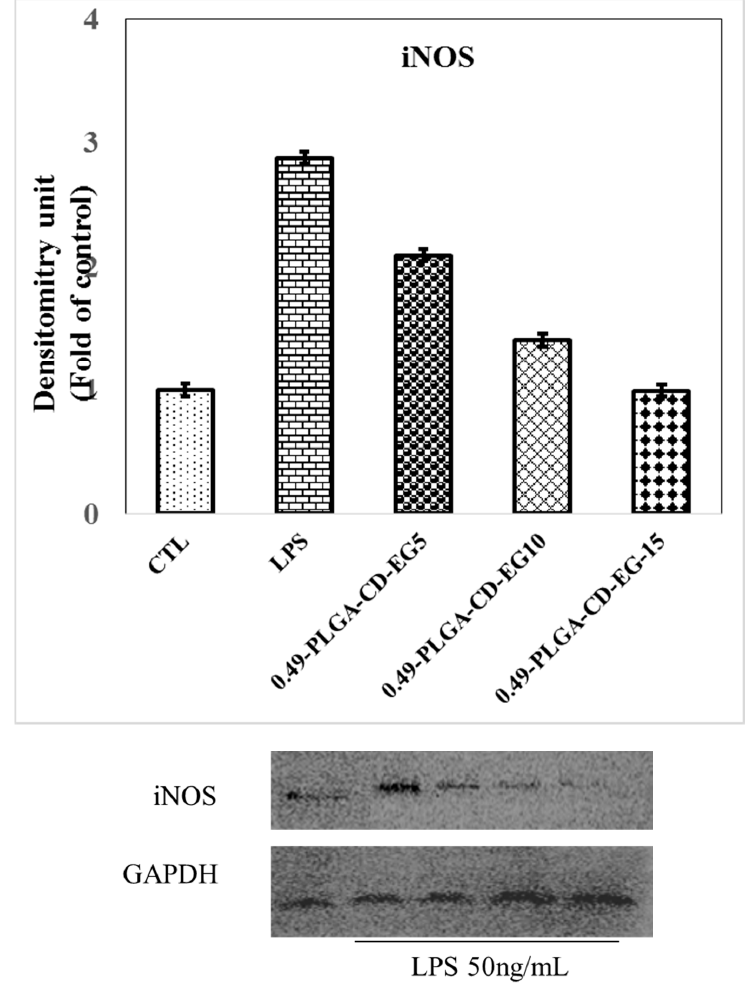
Figure 8. Effects of PLGA 0.49 -(CD-EG) formulations (1 mg/mL) on the expression of iNOS in BV-2 cells treated with 50 ng/mL of LPS for 24 h. Cultures were pretreated with PLGA 0.49 -(CD-EG) for 24 h before the addition of LPS. Bars represent the mean ± standard errors from three independent experiments. Densitometry analyses are presented as the relative ratio of protein/GADPH protein and are represented as fold changes with respect to the control.